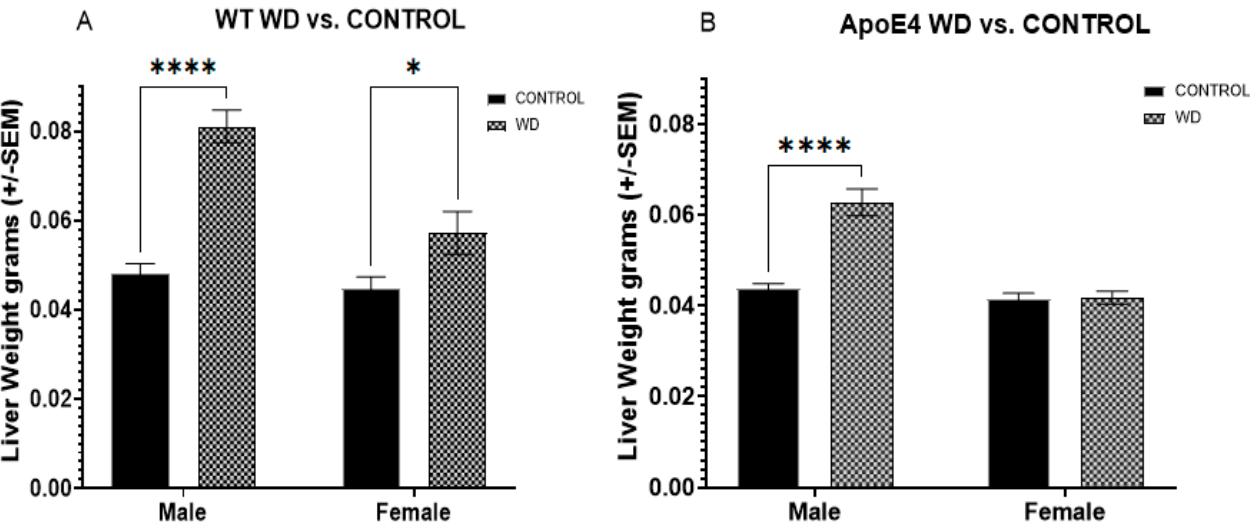
Figure 4. Liver weights. Male and female WT ( A ) and male ApoE4 ( B ) animals exposed to WD were found to have significantly larger livers than those on control. Female ApoE4 animals did not show this increase in liver weight. * p < 0.05, **** p < 0.0001.2.3. Selective Effects of WD on Liver Weights in ApoE4 Males and WT Animals.